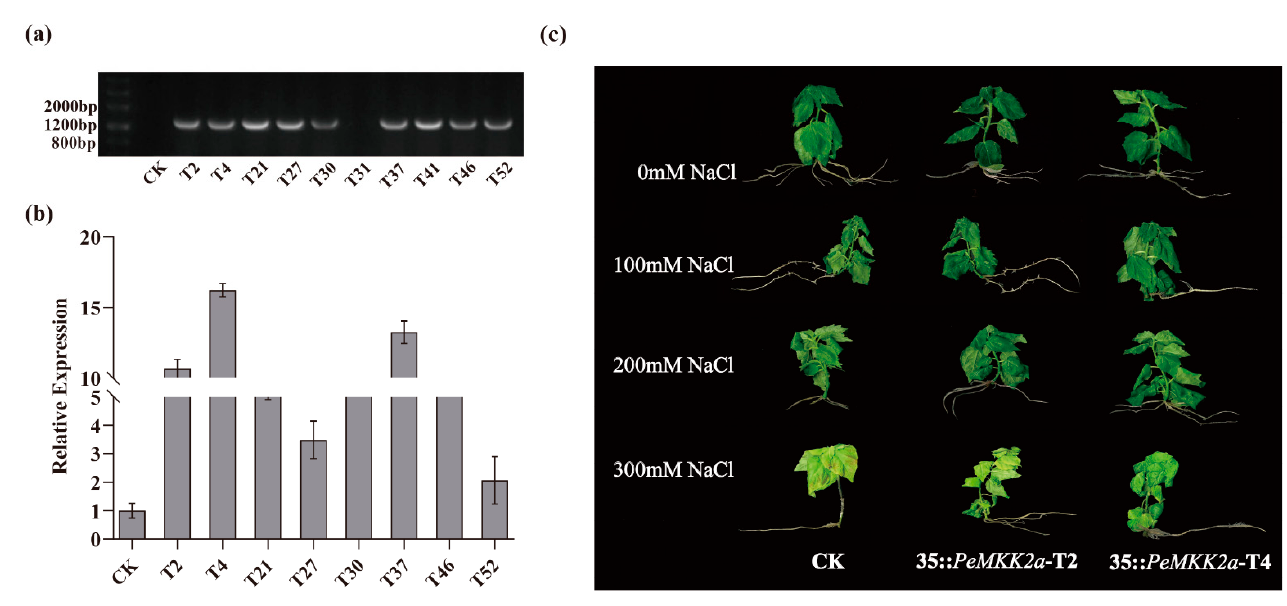
Figure 5. ( a ) Genomic DNA-level detection. ( b ) The expression level of PeMKK2a in eight transgenic lines and the CK, according to qRT ‒ PCR (CK, non ‒ transgenic poplar; T2, T4, T21, T27, T30, T37, T46, and T52, transgenic lines). ( c ) Phenotypic observations of transgenic plants under salt stress. (Unstressed poplar plants constituted the positive control. All the treatments included three biological replicates.)